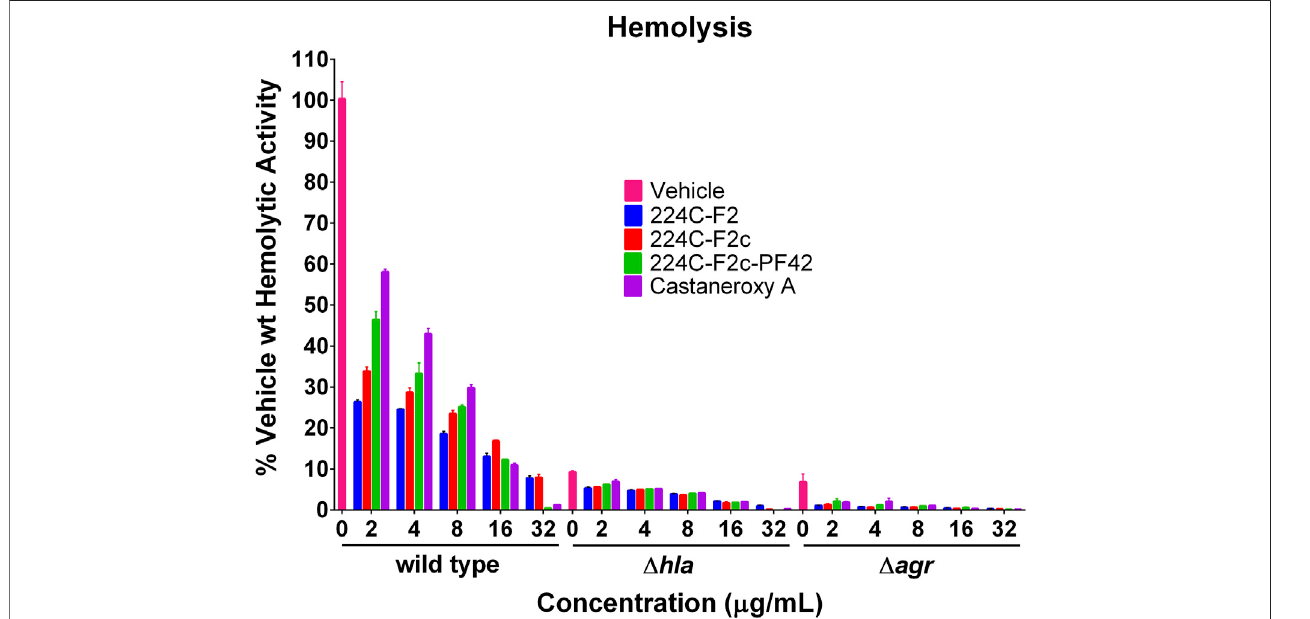
FIGURE9| CastaneroxyA( 1 )anditsparentfractionsinhibit S.aureus hemolyticactivityinwild-type, Δ hla ,and Δ agr strains.Thesupernatantsoftreatedculturesof three S. aureus strains were assessed for hemolytic activity against rabbit erythrocytes. Each treatment-concentration was performed in quadruplicate; the experiment was performed in duplicate on separate days. Shown is the result of one of the duplicates. Error bars represent SD.